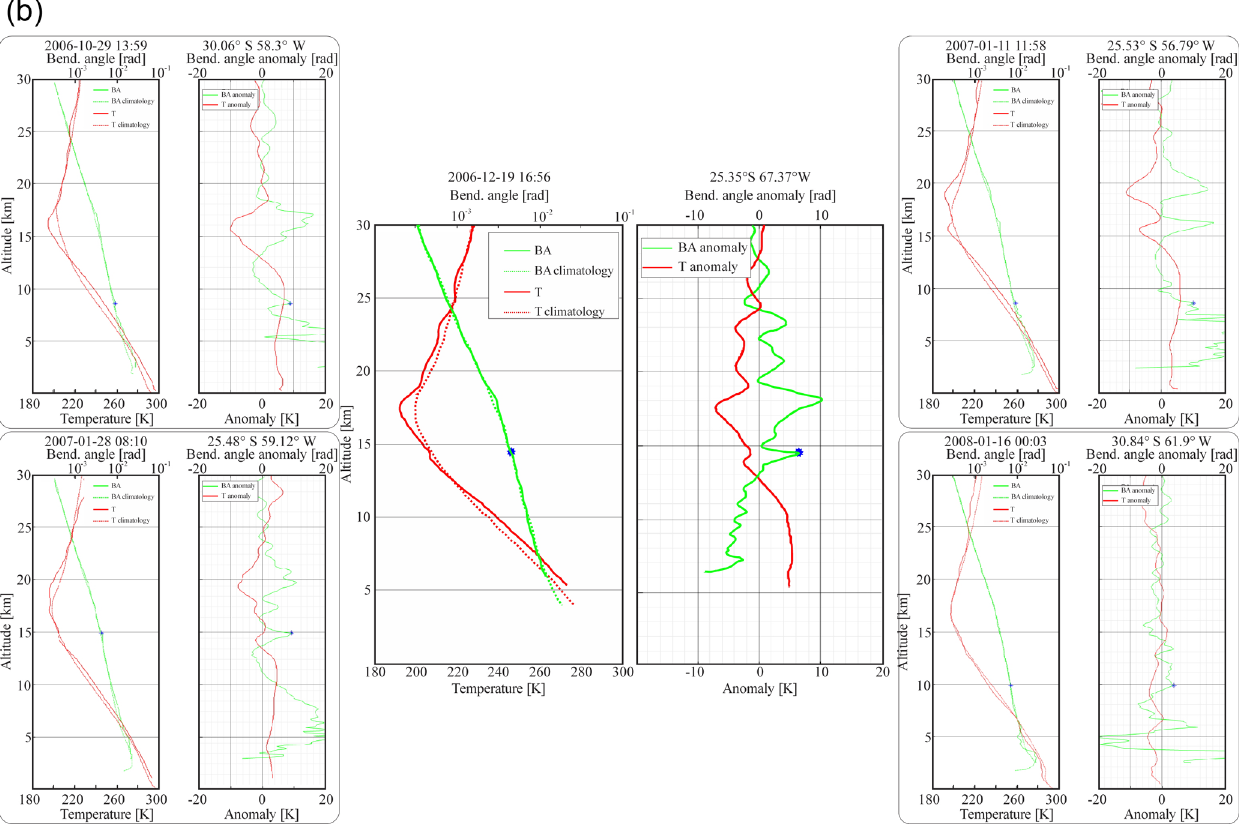
Figure 3. Pre-selected collocations between GPS RO profiles and convective developments in (a) the Alps region and (b) the Andes region. The figure shows absolute profiles and anomaly profiles for bending angle (green) and temperature (red) and the respective climatology profile (dotted). The cloud top height is indicated by a blue star. The pre-selected collocations for case studies are based on large-amplitude wave features in observed the RO T profiles. The two selected case studies (central panels) are based on the simultaneous absence of GW sources given by jets and